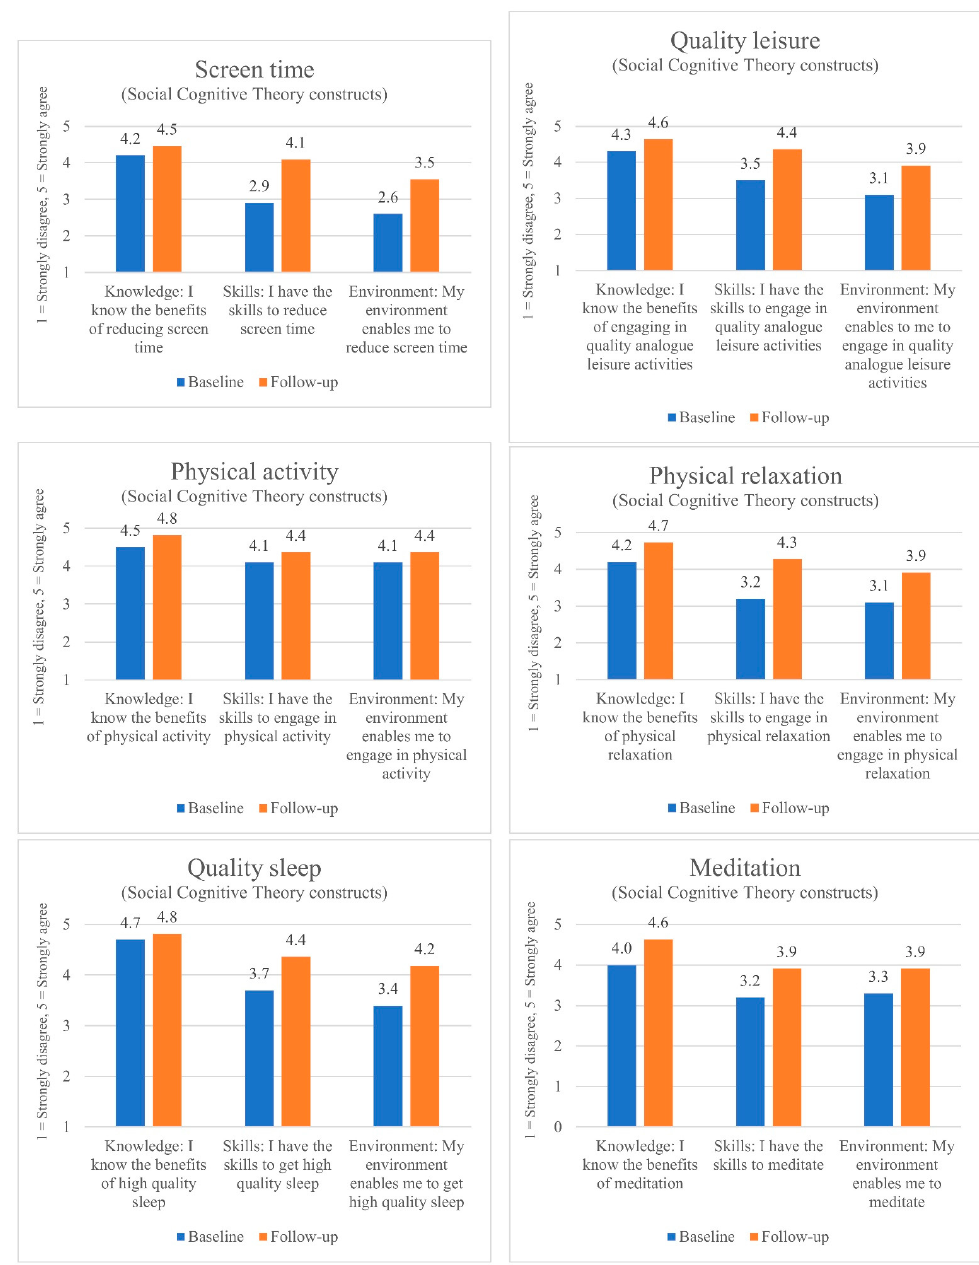
Figure 1. Changes in knowledge, skills and environment pre- and post-program.